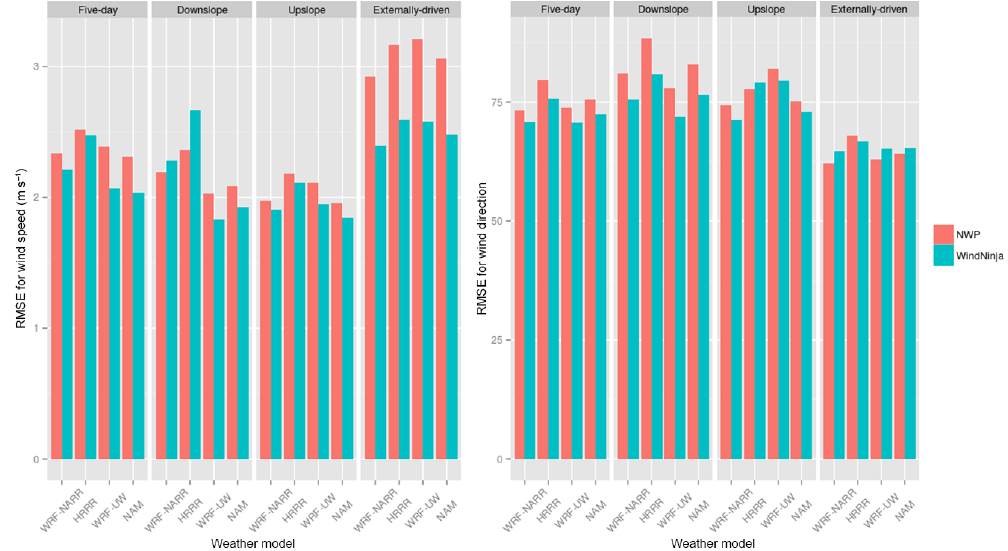
Figure 5. Root-mean-square error in wind speed (left) and wind direction (right) at Big Southern Butte for the 5-day evaluation period ( N = 4149), and downslope ( N = 1593), upslope ( N = 717), and externally driven ( N = 966) periods within the 5-day period. Sample size: N = number of hours × number of sensor locations.